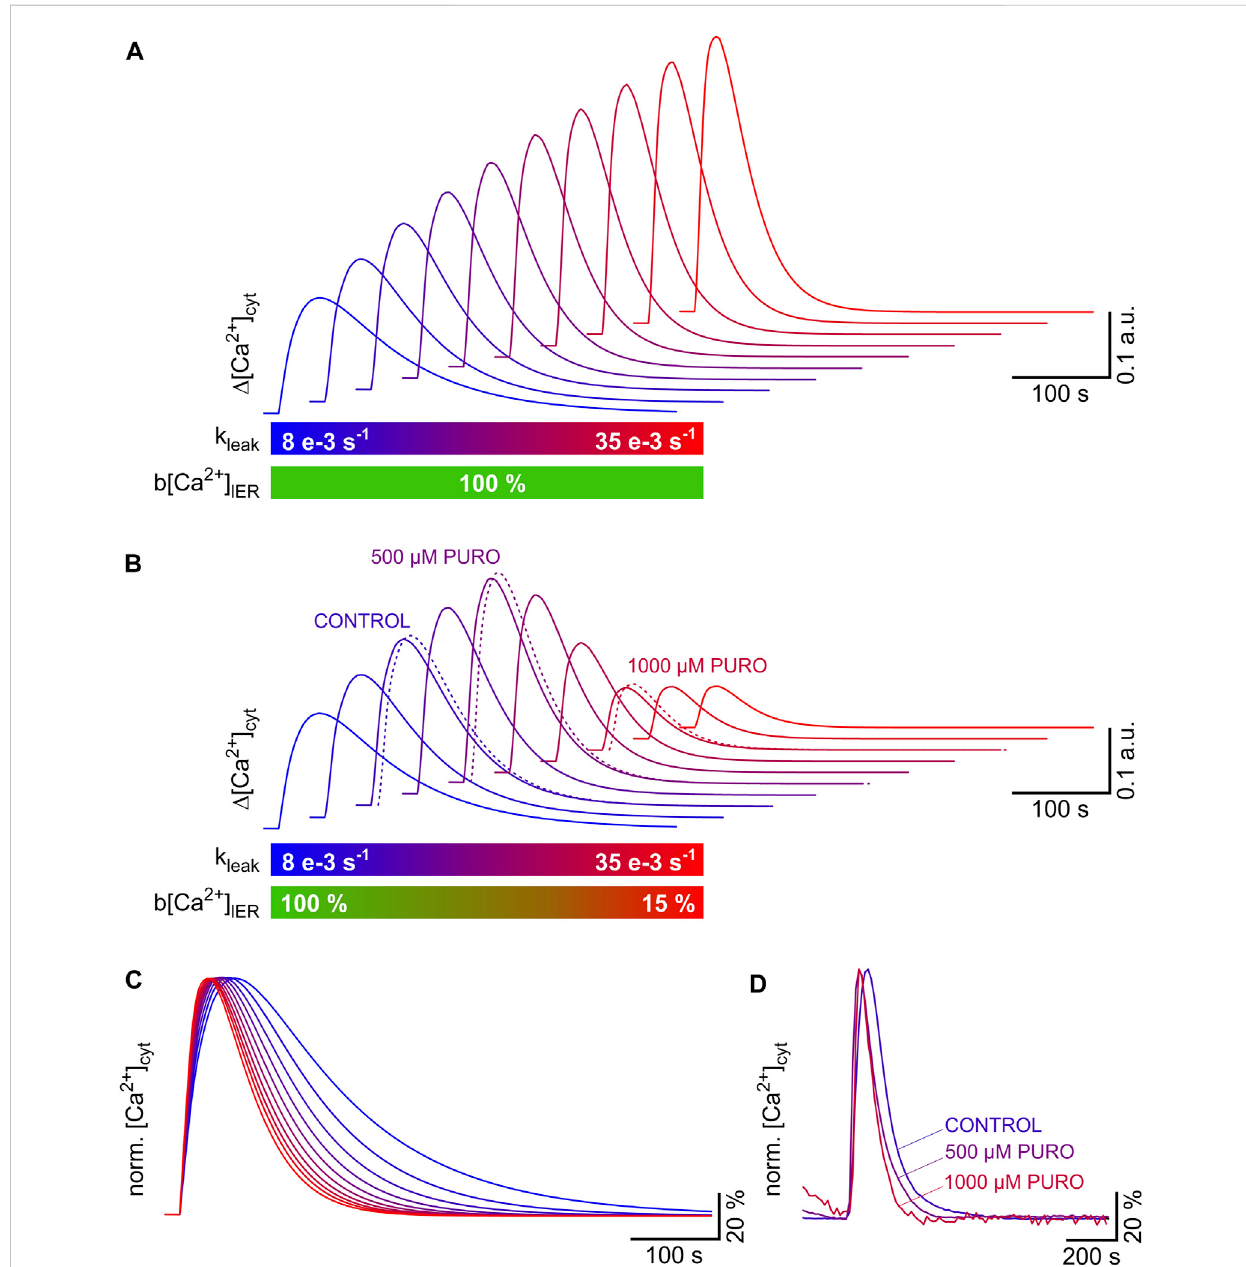
FIGURE 7 Ampli fi cationandattenuationofTG-inducedcytosolicCa 2+ transientsasaresultofprogressive increaseinERCa 2+ leakandlossofERCa 2+ content. Cytosolic Ca 2+ transients weremodelled usingtheBateman equation (Eq.15).TheincreaseinERCa 2+ leakwassimulatedbyraising k leak from8e − 3 s − 1 to 35 e − 3 s − 1 in steps of 3 e − 3 s − 1 . The Ca 2+ clearance (k clear , 28 e − 3 s − 1 ) was assumed to be constant. ER Ca 2+ levels (b[Ca 2+ ] lER ) were either kept constant or reduced from 100% to 15%. (A,B) A progressive ampli fi cation of theTG-induced cytosolic Ca 2+ transients is evident when the ER Ca 2+ leak increases and ER Ca 2+ levels remain constant (A) . The inevitable loss of ER Ca 2+ , which follows the increase in Ca 2+ leak, counteracts this ampli fi cation, and the processiseventuallyreversedresultingintheattenuationoftheTG-inducedcytosolicCa 2+ transients (B) .Theswitchfromampli fi cationtoattenuationof TG-inducedcytosolicCa 2+ transientswasalsoobservedinHEK-D1ERcellsexposedtoPURO(seeFigure4).Toillustratethisphenomenon,cytosolicCa 2+ transients obtained in HEK-D1ER cells exposed to PURO are superimposed in (B) (dotted lines: CONTROL, 500 µM PURO, 1000 µM PURO). The parameters k leak and b[Ca 2+ ] lER are colour coded below graphs in (A,B) . (C,D) The cytosolic Ca 2+ transients shown in (B) were normalised to illustrate the fact that theduration and the time to peak of theTG-induced cytosolic Ca 2+ transients are reduced as the ERCa 2+ leakincreases (C) Same colour